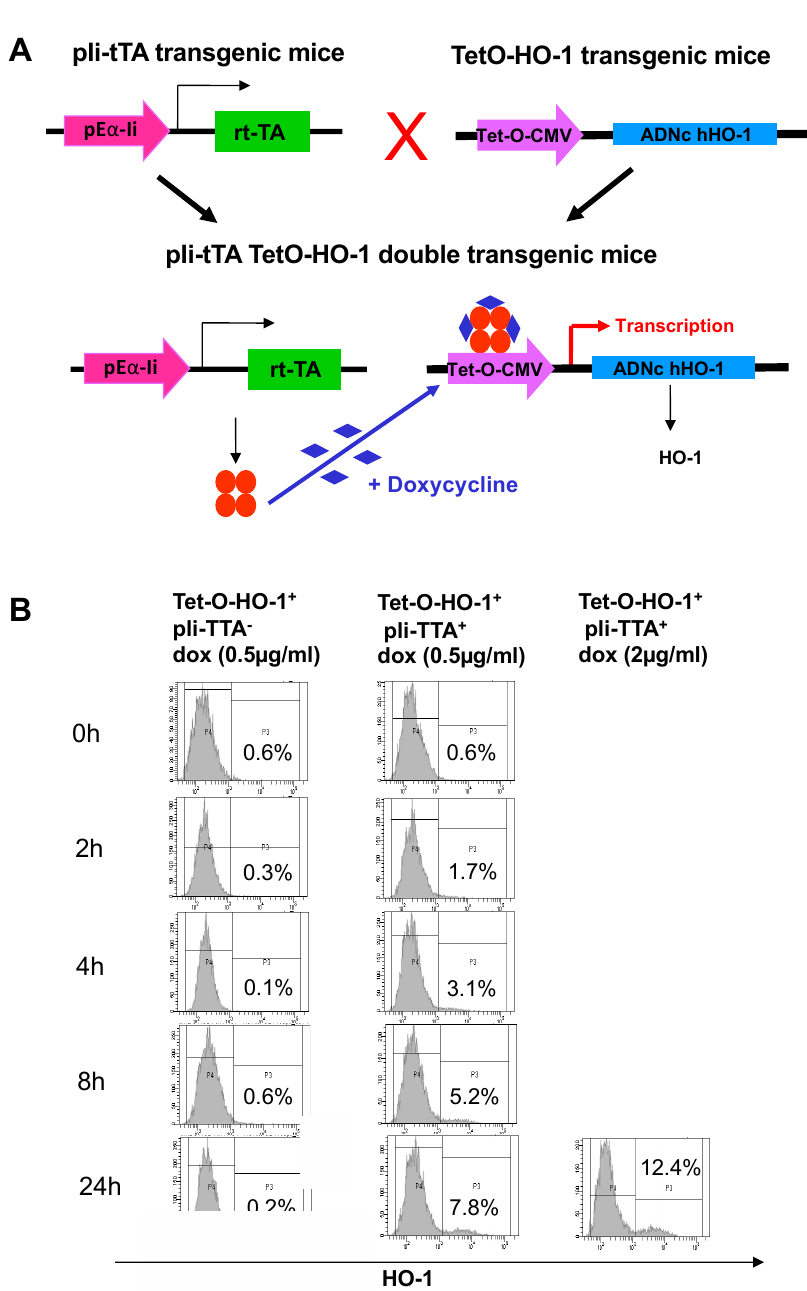
Figure 2. In vitro doxycycline treatment of splenic CD11c + DCs from double transgenic TetO-HO-1 + pIi-tTA + NOD mice induces HO-1 expression. ( A ) Schematic representation of the transgenic mouse strains used in the study. pIi-tTA are transgenic mice in which the tetracycline transactivator ( tTA ) gene is under the control of the Major Histocompatibility Complex II (MHC-II) invariant chain (E α -Ii) promoter [24]. TetO-HO-1 are transgenic mice in which the human homx-1 cDNA was cloned downstream a hybrid cytomegalovirus (CMV)-Tet operator rtTA. Double transgenic mouse strain show induction of HO-1 expression in MHC-II + cells in the presence of doxycycline (DOX). ( B ) Splenic CD11c + DCs from single transgenic Tet-O-HO-1 + pli-tTA − or double transgenic TetO-HO-1 + pIi-tTA + NOD mice were cultured with doxycycline for 24 h and analyzed by flow cytometry for HO-1 expression. One representative experiment out of two is shown.